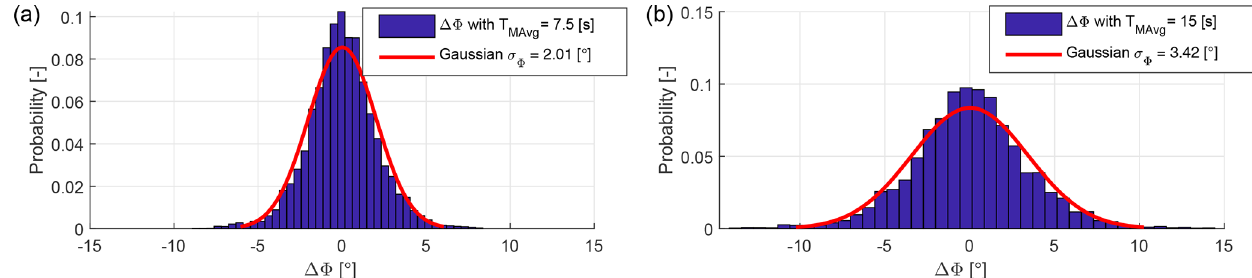
Figure 8. Distribution of wind direction uncertainties, i.e., difference between the actual turntable position and its filtered value (which is the wind direction input to the controller) for T MAvg = 7 . 5s (a) and T MAvg = 15s (b)